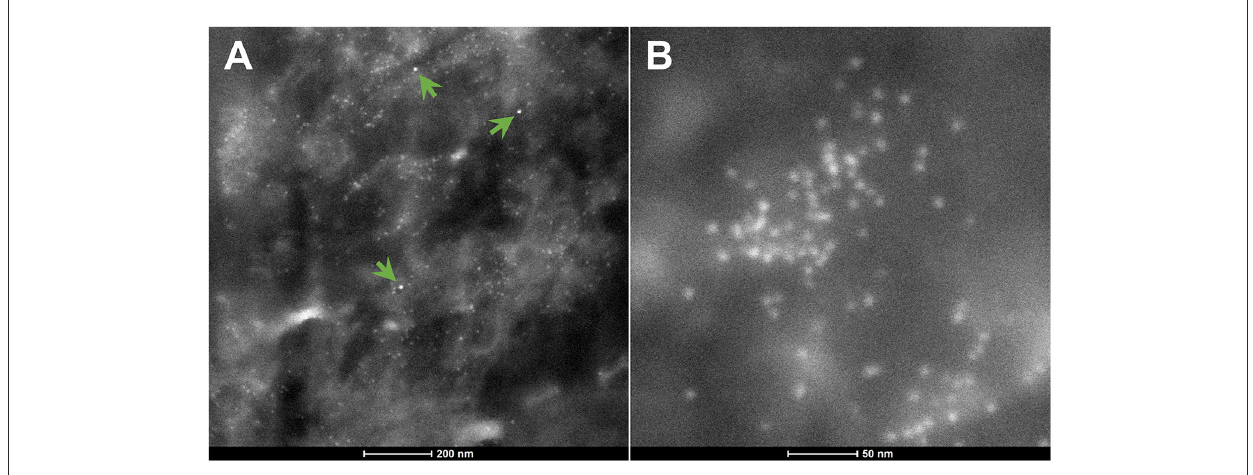
FIGURE9 (A) The green arrows indicate three Hg-NPs that stand out from surrounding iron NPs. (B) An area of Fe-NPs. These NPs are magnetic.